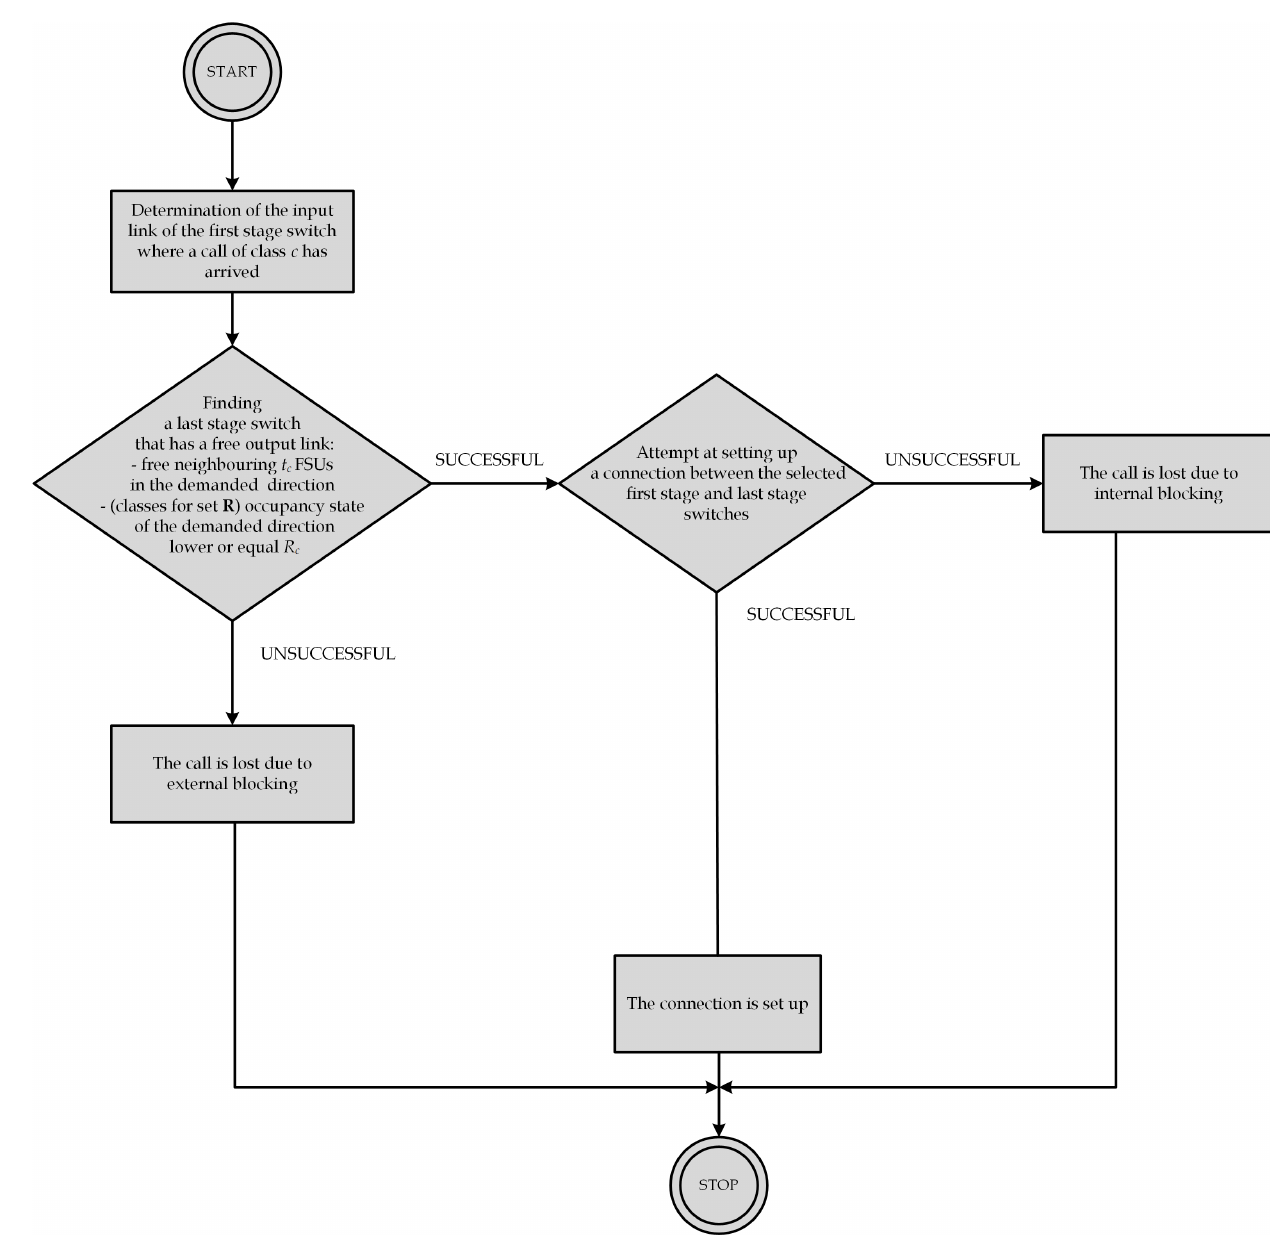
Figure 6. Point-to-point path choice